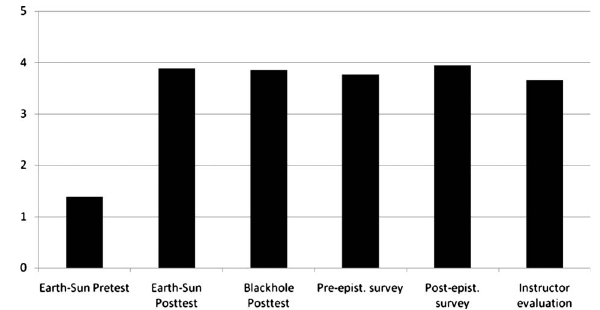
FIG. 4. Average scores for all research methods used in this study.